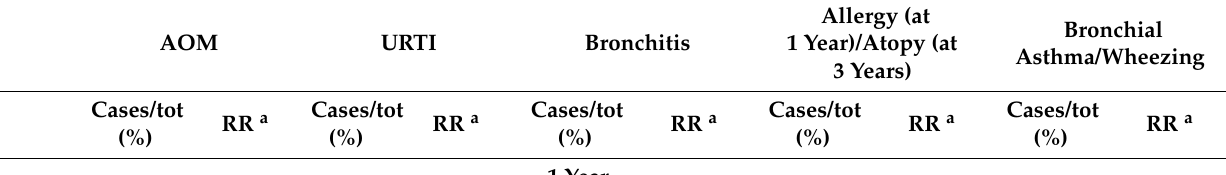
Table 4. Association between nasal mucosa cytological composition at birth and development of acute otitis media (AOM), upper respiratory tract infections (URTI), bronchitis, allergy, and bronchial asthma/wheezing during the first year of life (top part of the table) and the first 3 years of life (bottom part of the